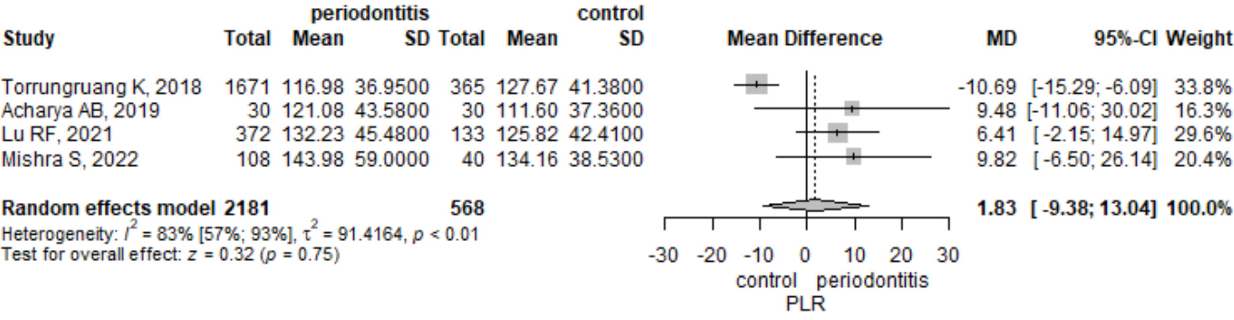
Figure 3. Platelet to leucocyte ratio-mean difference between periodontitis and control subjects.